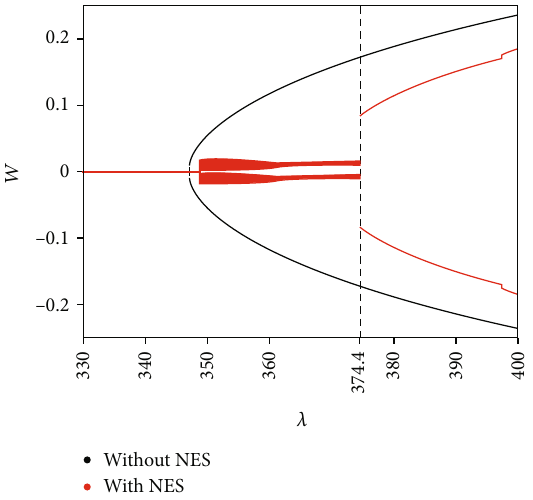
Figure 15: Bifurcation diagram in the condition of designed